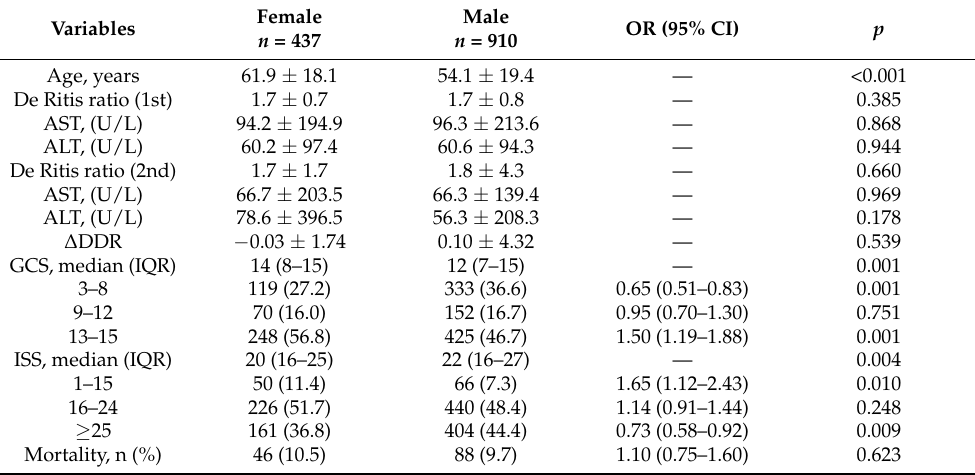
Table 2. Comparison of the injury characteristics in male and female patients.